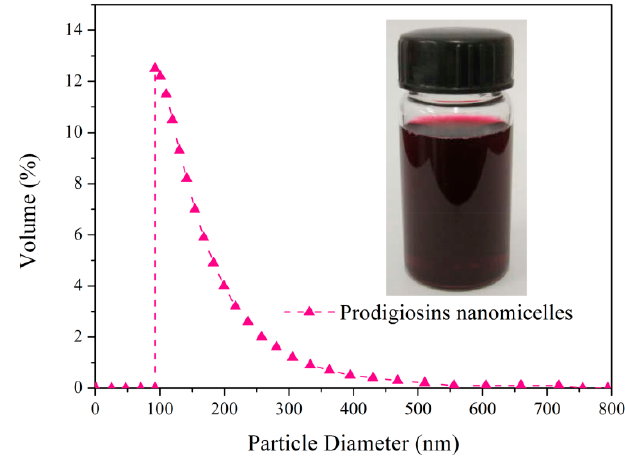
Figure 3. Particle size distribution of prodigiosins nanomicelles.